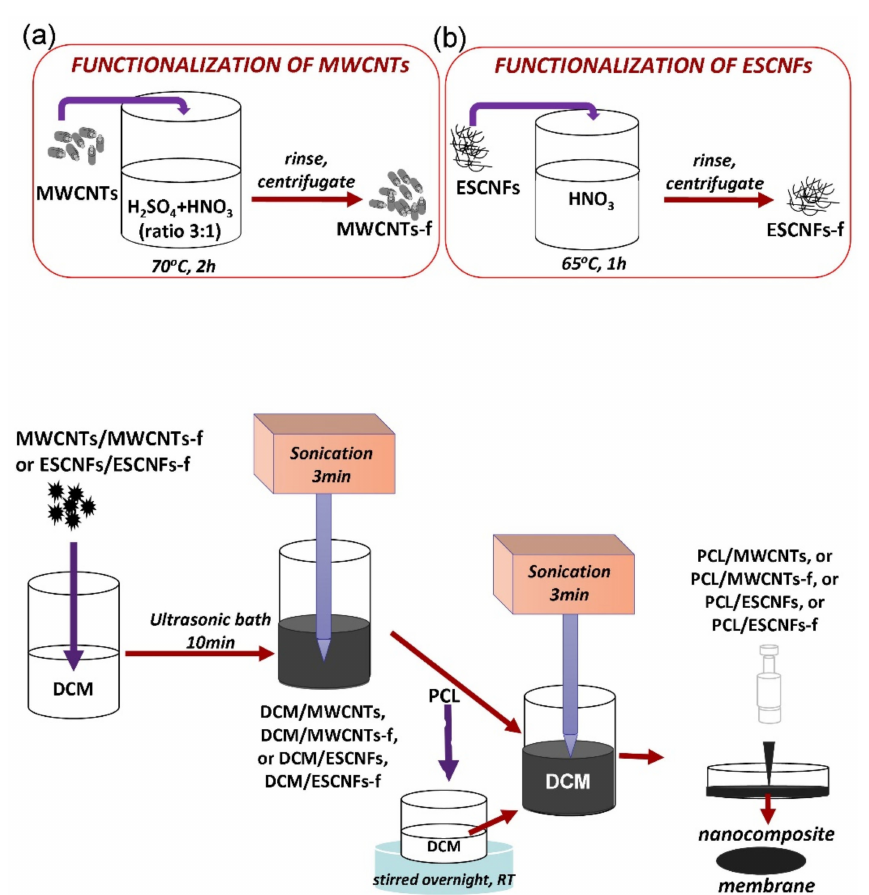
Figure 1. The nanocomposite membranes fabrication process; the inserts present a method of functionalization of carbon nanoadditives: ( a ) functionalization of MWCNTs; ( b ) functionalization of ESCNFs. The obtained membranes are shown in Figure 2a,c–f.